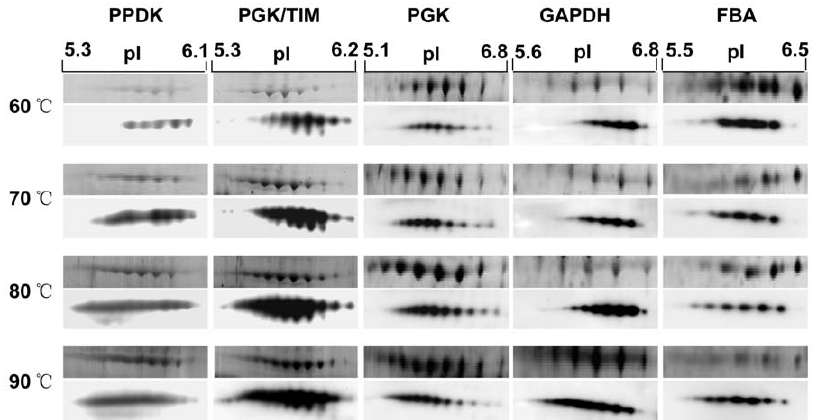
Figure 5. Close-up images of 2-DE and 2-DE Western blots of the five typical proteins with iso-spots and the significant changes in spot volumes responding to temperature. For each protein, the upper panels are the 2-DE images and the lower panels are the 2-DE Western blot images.